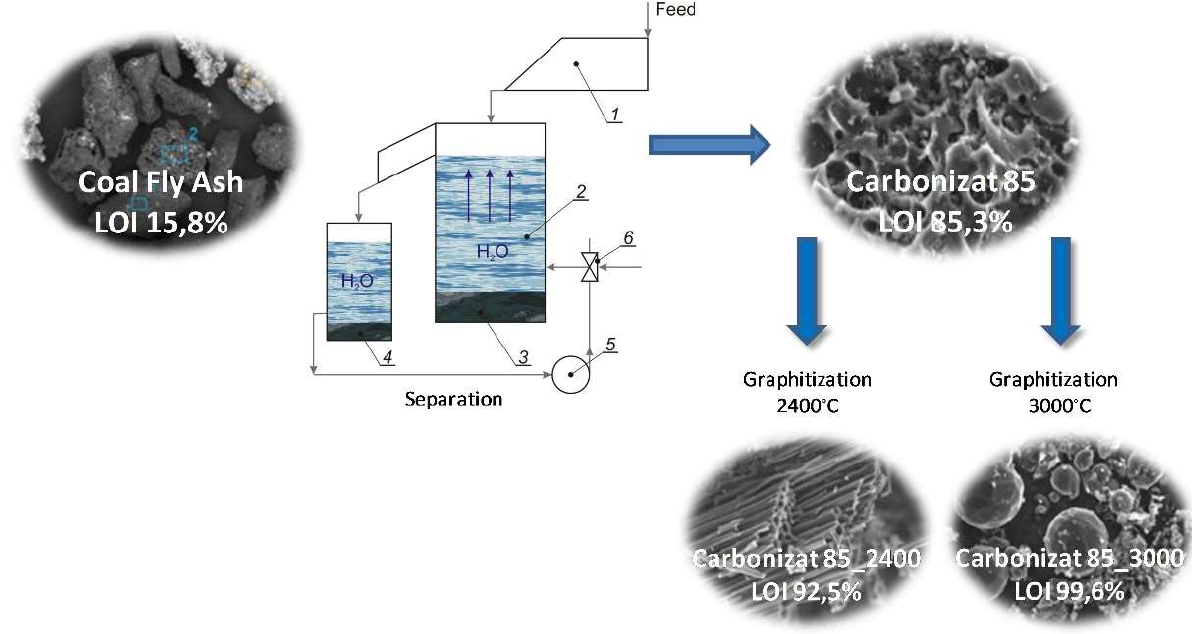
Figure 1. The research methodology for separation in the rising water stream (1—Feeder; 2—Separator; 3—Sediment (bottom product); 4—Overflow (top product); 5—Pump; 6—three-part valve).